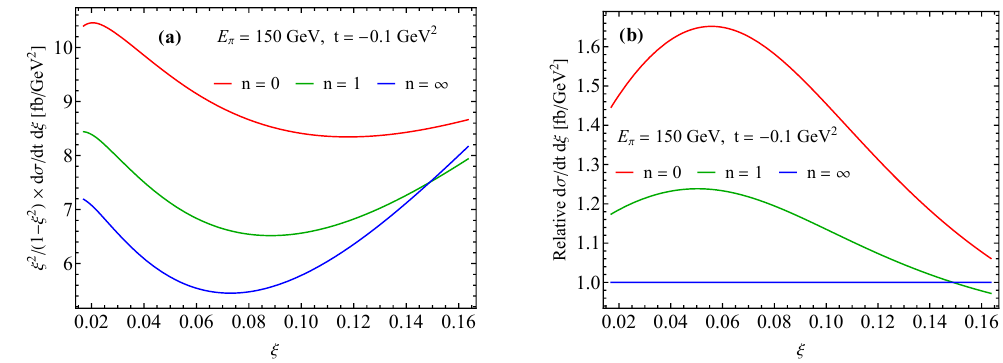
Figure 27. (a) Absolute and (b) relative distributions of ξ at t = − 0 . 1 GeV 2 for 150 GeV pion beam, for the three different GPD models shown in figure 26. The relative distribution in (b) is obtained by dividing each curve in (a) by the one with n = ∞